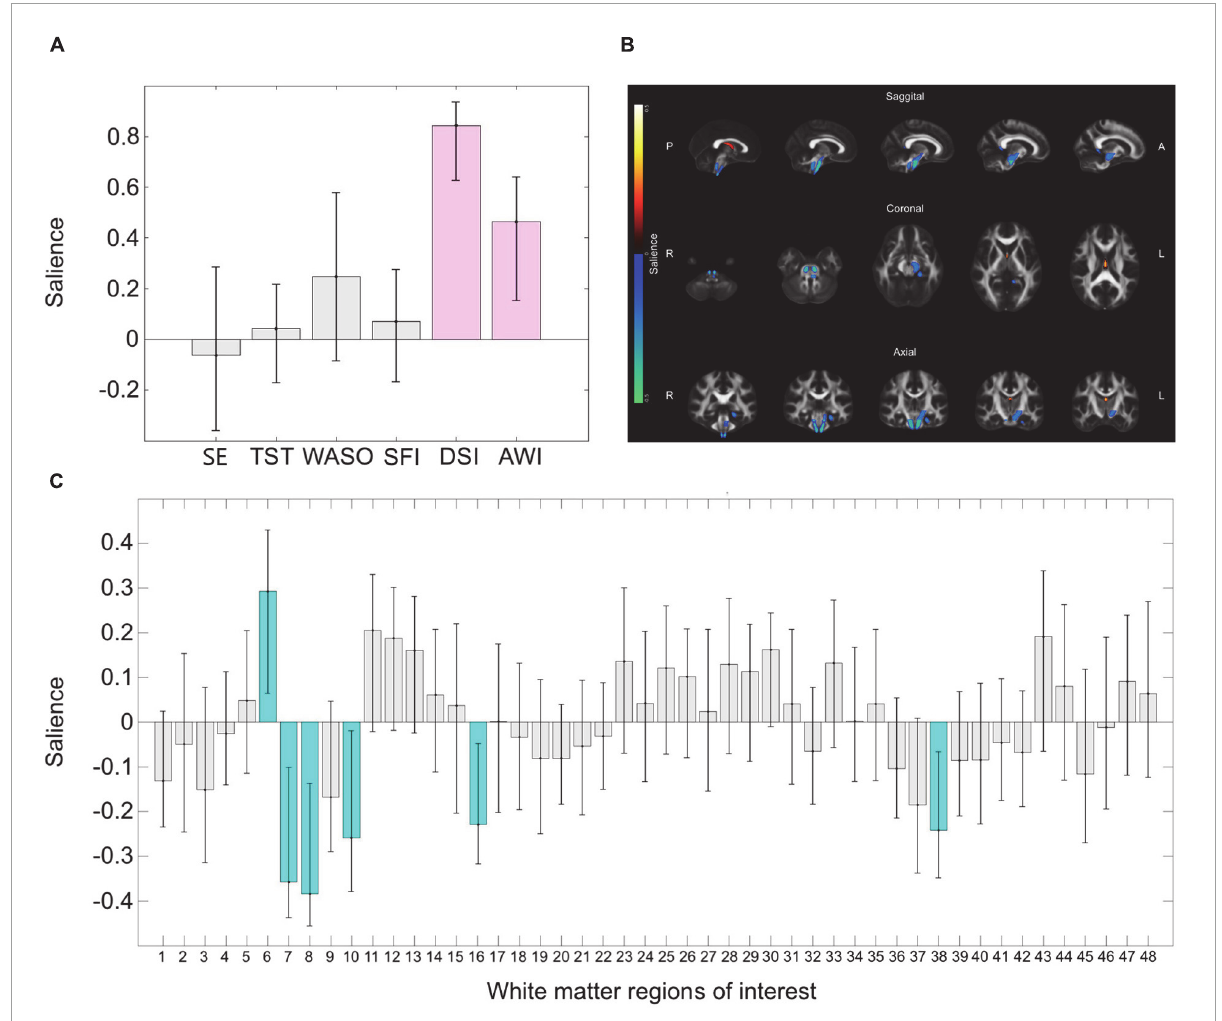
FIGURE3 Multivariate correlations between sleep measures and regional fractional anisotropy. Figure displays the results from the multivariate PLS-C analyses on UHR individuals linking covariance in a pattern of sleep disturbances with fractional anisotropy (FA) in 48 regions of interest. (A) The pattern of variance six measures of sleep disturbances show that higher disturbed sleep index (DSI) and disturbed awakening index (AWI) marked with purple contributes reliably to the pattern, as the confidence interval does not cross zero. (B) The pattern of sleep disturbances is linked to a pattern of regional covariance in FA. The regions of interest which contributes reliably are visualized with the regions contributing reliably projected on a standard brain derived from JHU white matter atlas. Regions colored yellow indicates higher FA, and blue color indicates lower FA. Reliably contributing regions are fornix (higher FA) and left and right corticospinal tract, left cerebral peduncle, left medial lemniscus, and left cingulum (hippocampus) (lower FA). (C) The pattern of covariance in all 48 regions of interest, with the regions contributing reliably marked in turquoise. A list linking the numbers to the regions are displayed in the Supplementary Text 3 . SE, sleep efficiency; JHU, John Hopkins University; L, left; R, right; SFI, sleep fragmentation index; TST, total sleep time; WASO, wake after sleep